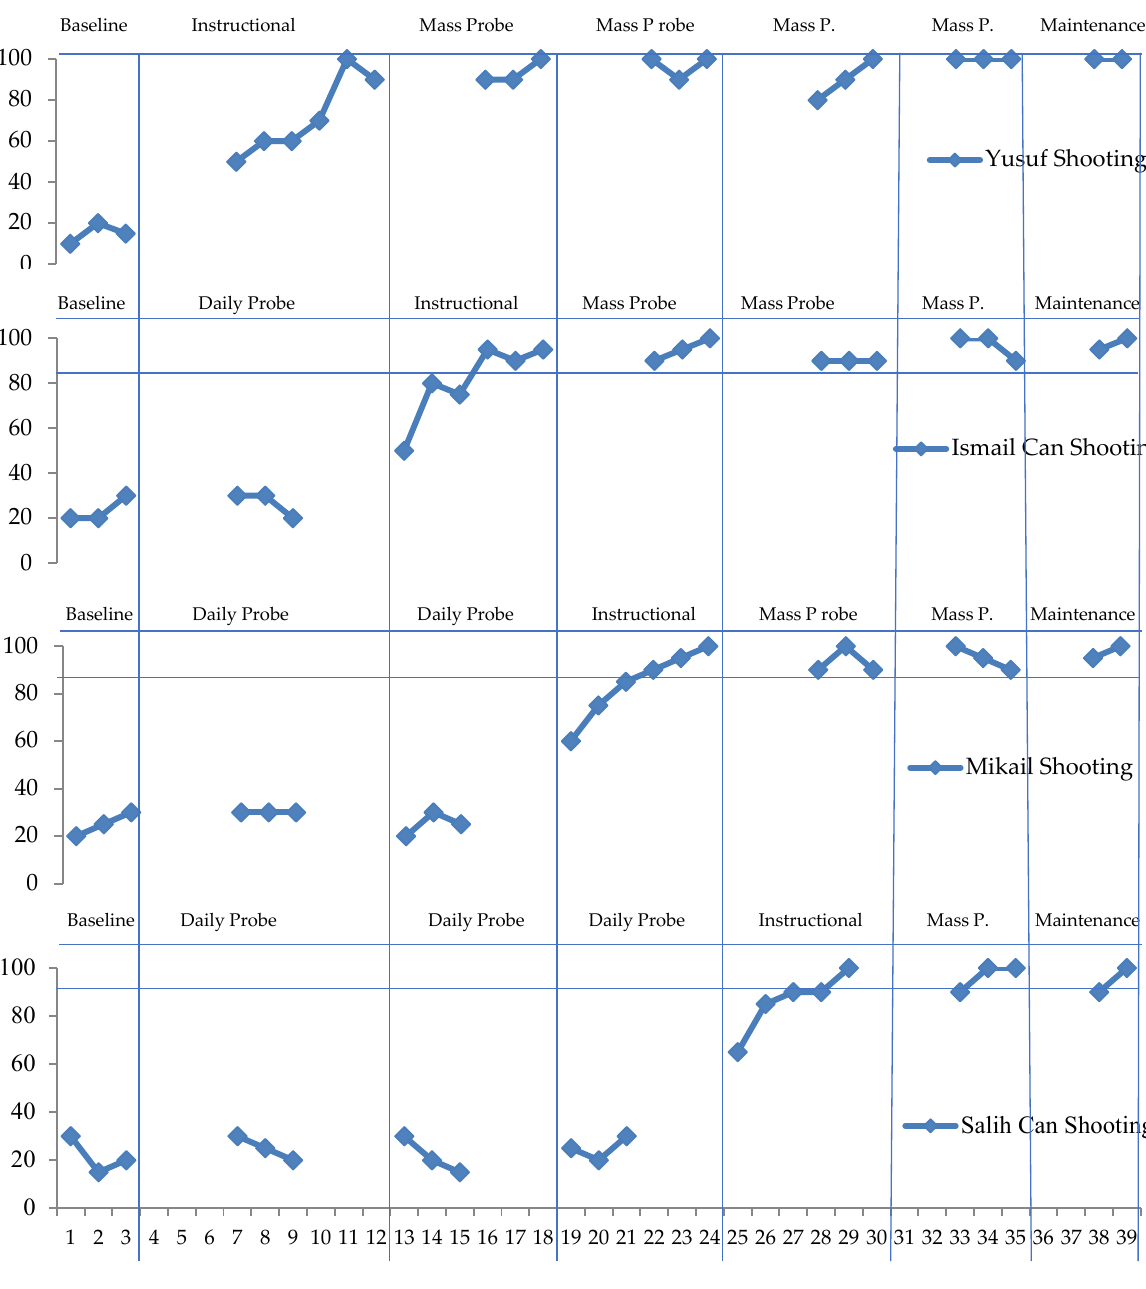
Figure 1. Data on the instructional of shooting skills in basketball maintenance.